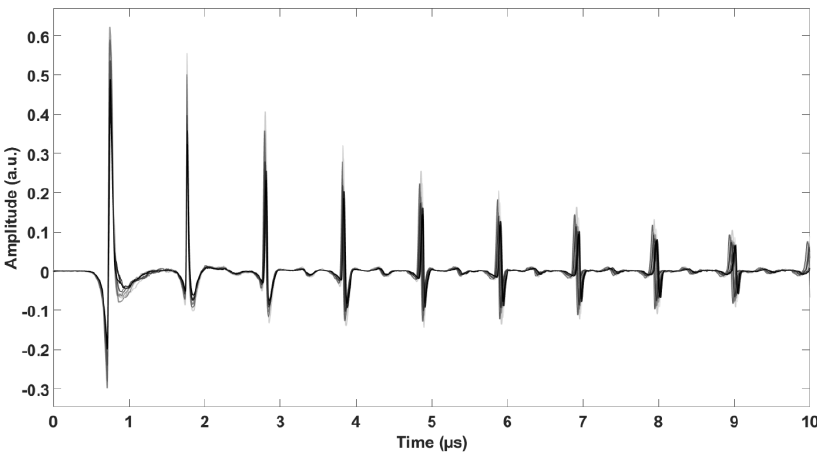
Figure 7. A few typical bandpass − filtered A − scans from the online LUS-based grain-size gauge installed in the Borlänge hot strip mill.